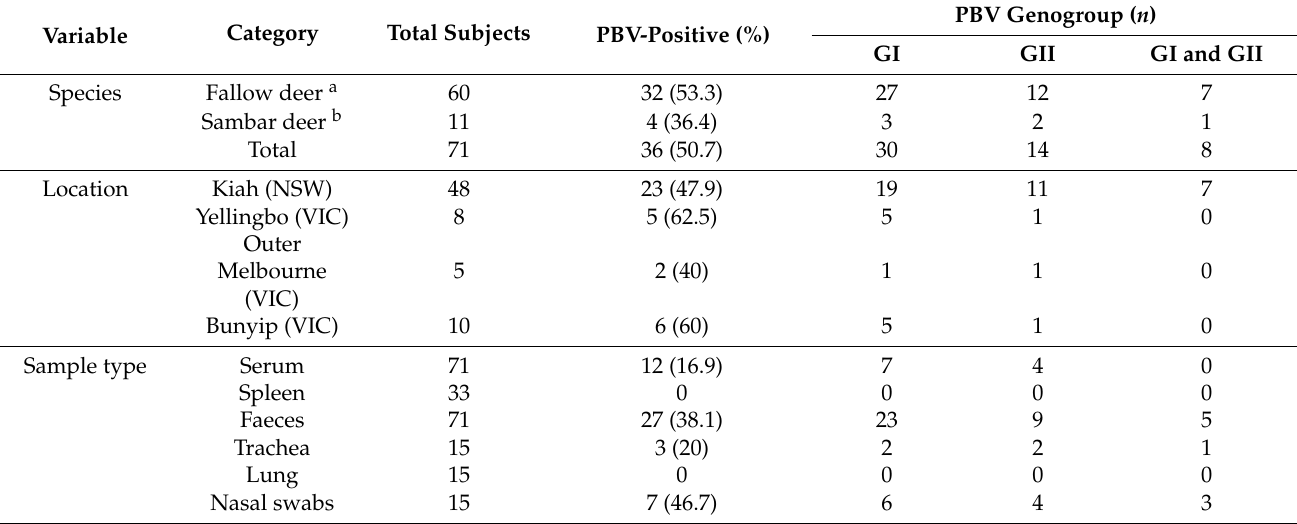
Table 2. Diagnostic test results for PBV detection in deer.